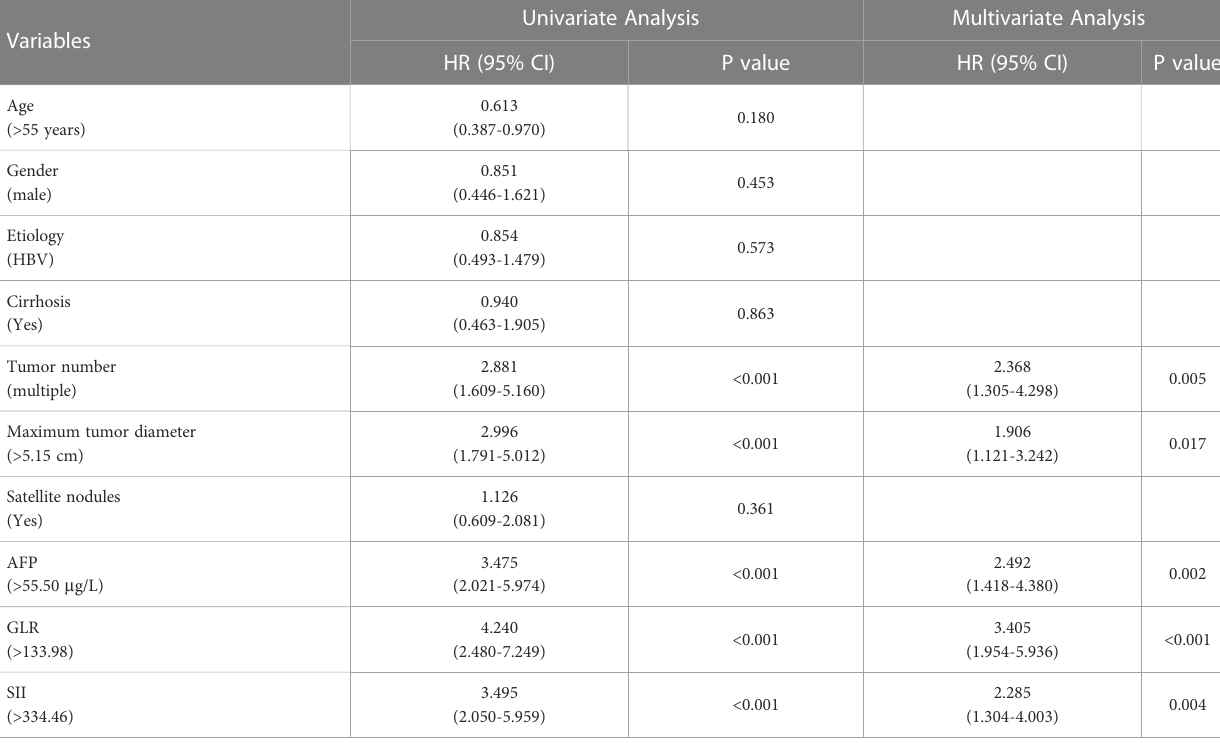
TABLE 3 Univariate and multivariate Cox regression analysis of risk factors for recurrence-free survival of HCC patients after LT. Univariate Analysis Multivariate Variables